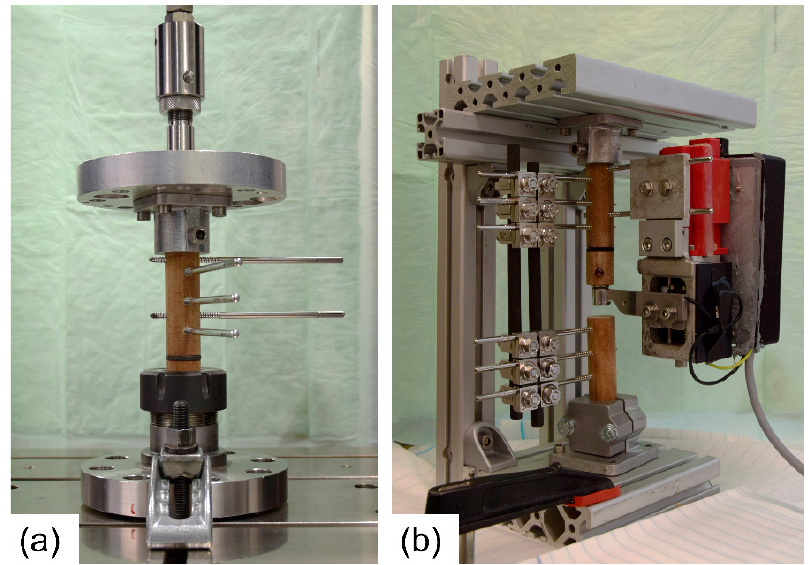
Figure 4. ( a ) Test setup in the universal testing machine with foam spacer (black) in the simulated experimental defect to determine actual stiffness values; ( b ) test setup with the active